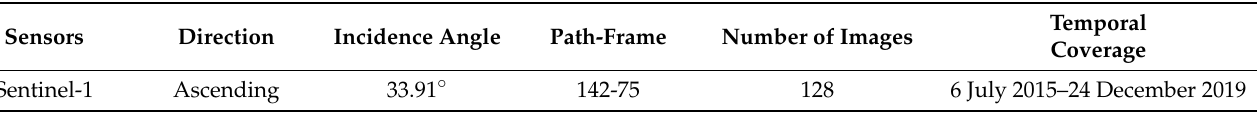
Table 1. Acquisition dates and parameters of the collected Sentinel-1 images.